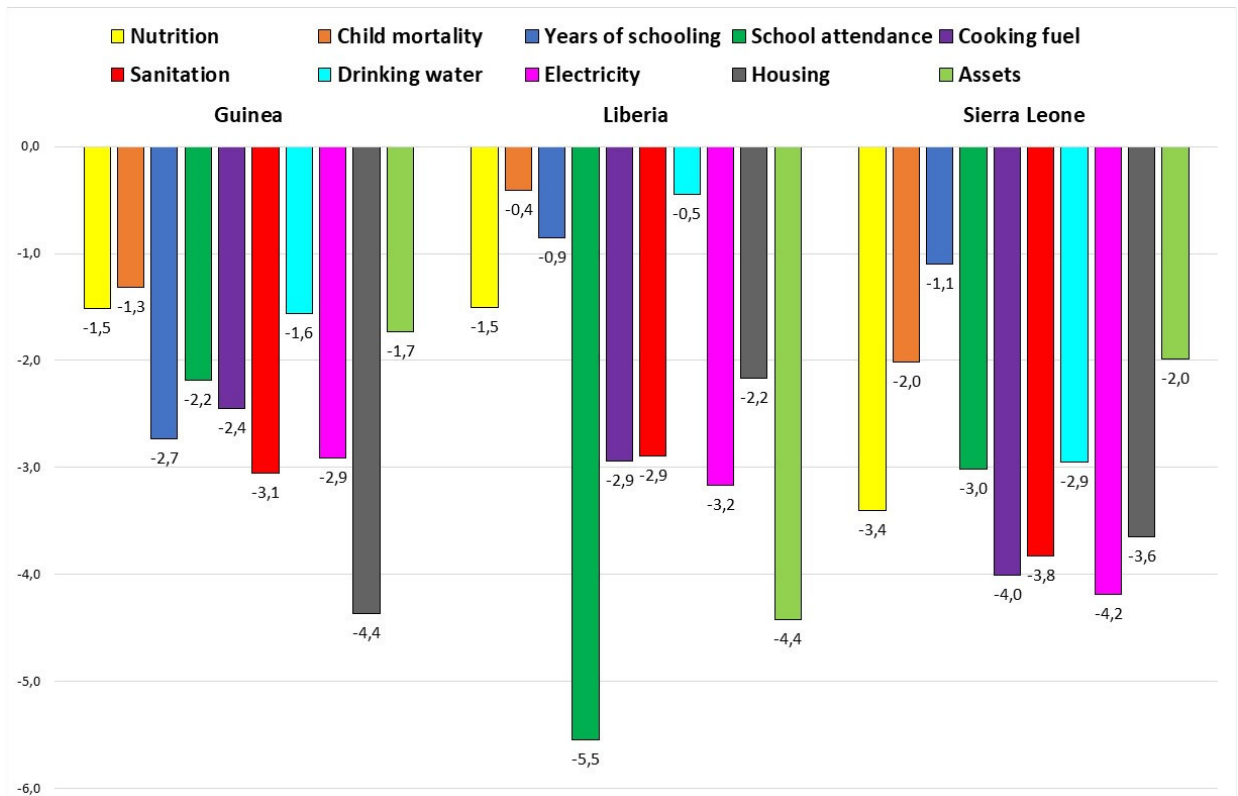
Figure 10. Reduction in each multidimensional poverty indicator. Notes: Annualized changes. This table provides censored headcount ratios for each of the 10 MPI indicators. Censored headcount ratios are the proportion of people who are MPI poor and experience deprivations in each of the indicators. Source: Alkire et al. (2020) [16,29].